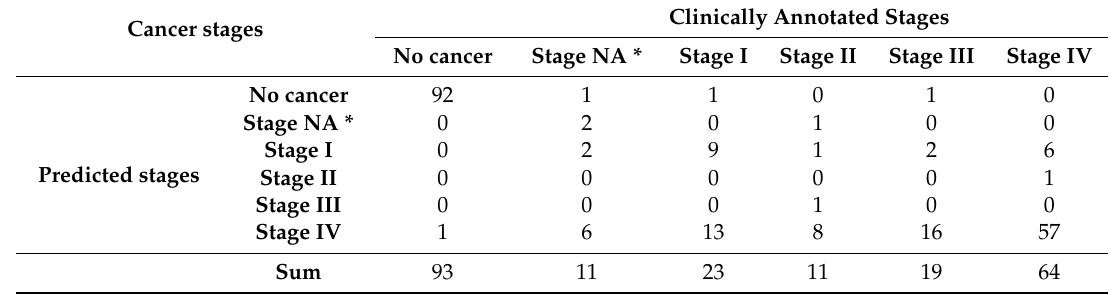
Table 2. Number of clinically annotated and predicted healthy and lung cancer patients, including their stages, as obtained using the 6-protein classifier.